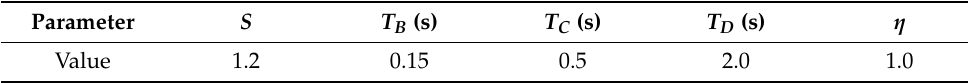
Figure 11. Capacity curves of the two investigated case studies (blue for the wall with openings and black for the church). Table 1. Parameters used to define the Eurocode8 response spectrum.